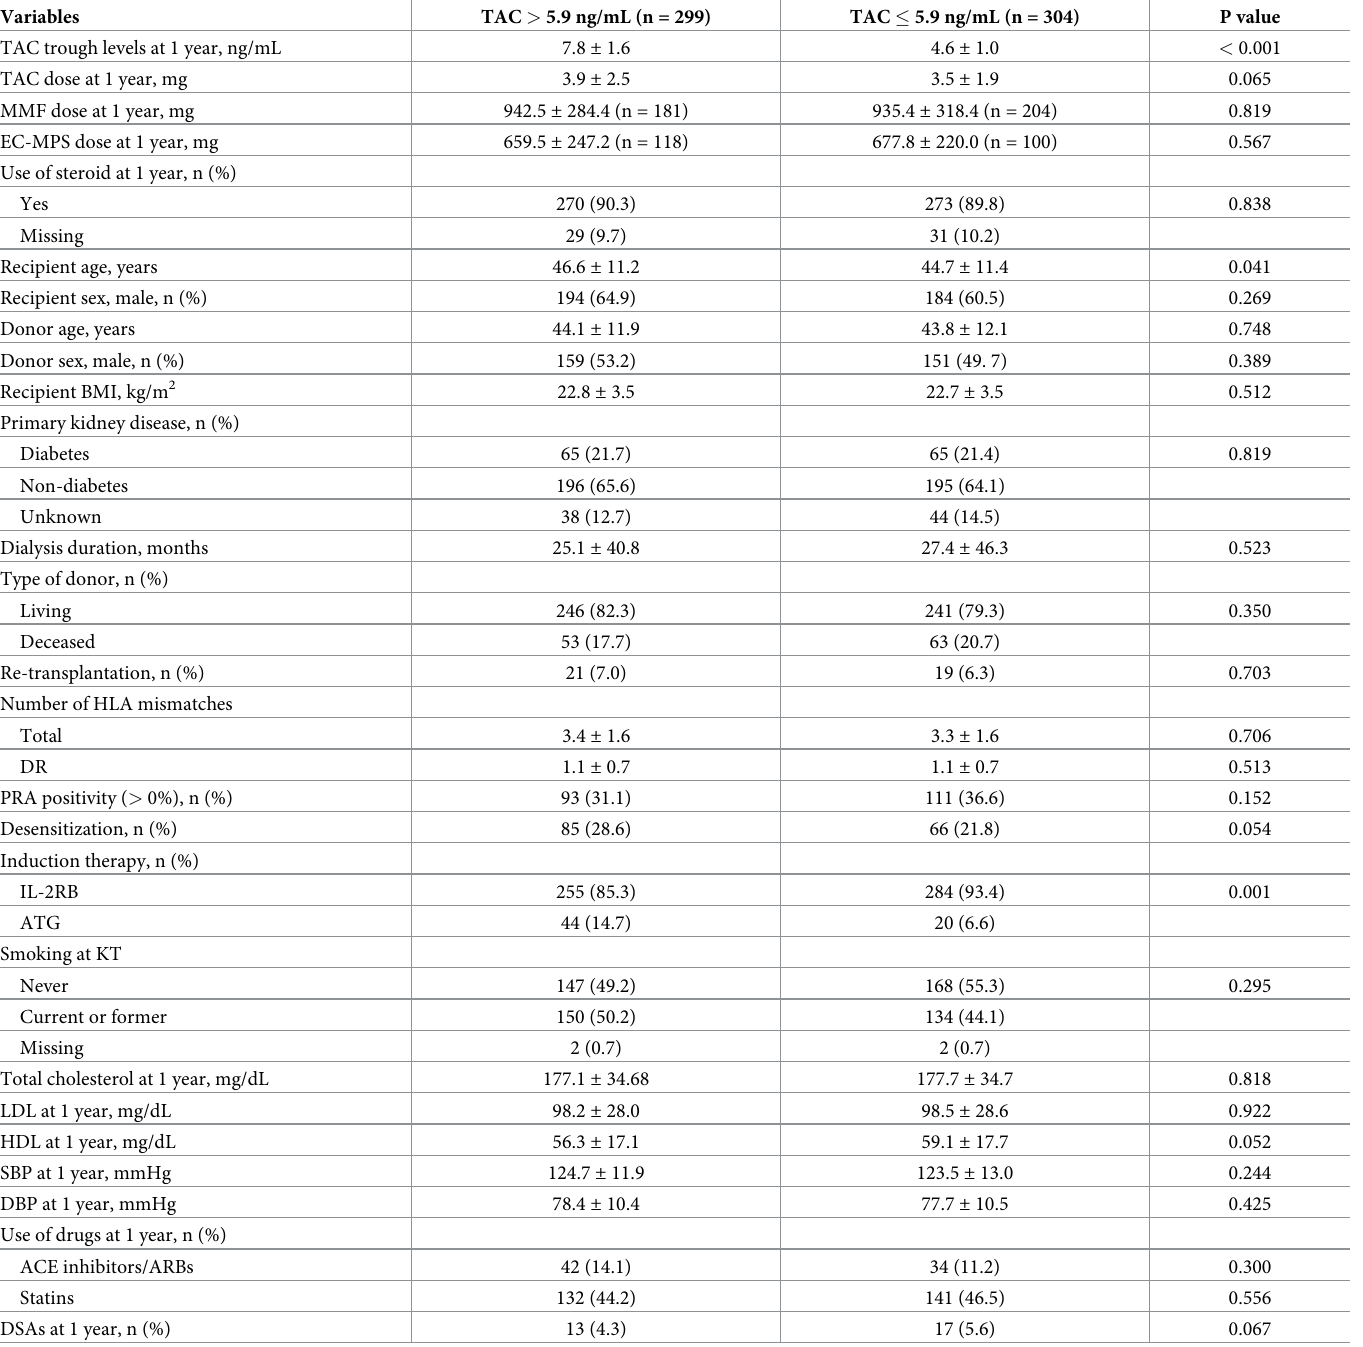
Table 1. Baseline